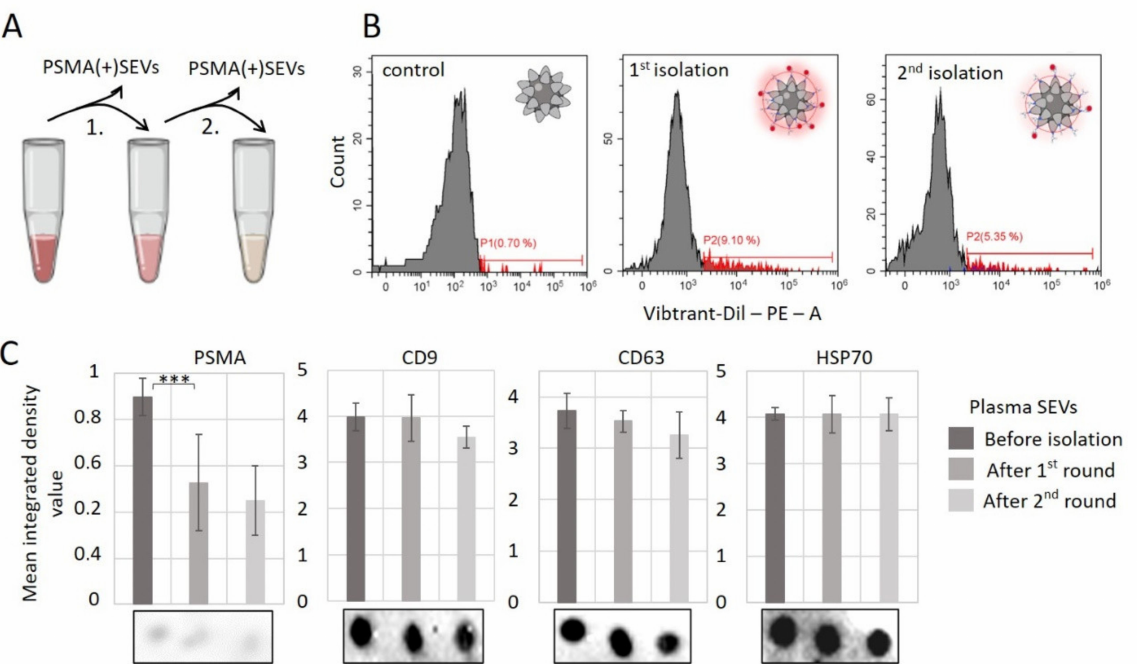
Figure 6. Evaluation of the efficiency of the isolation of PSMA(+)SEVs from the total population of plasma SEVs. ( A ) Experiment scheme. ( B ) Effectiveness of two consequent rounds of SPMA(+)SEVs capture was assayed by flow cytometry. SPMB non-functionalized by PSMA–Apt was stained with SEVs and assayed as a negative control. ( C ) The effectiveness of PSMA(+)SEVs depletion from the total population of plasma SEVs through two rounds of incubation with PSMB–PSMA–Apt complexes was analyzed by dot blotting. The amounts of PSMA, CD9, CD63, and HSP70 were assayed in parallel. Representative images from one sample’s analysis are presented. All images were digitalized by ImageJ, the results were averaged within the groups, the statistical significance of the difference between paired groups was assayed using the Mann–Whitney test: *** p <